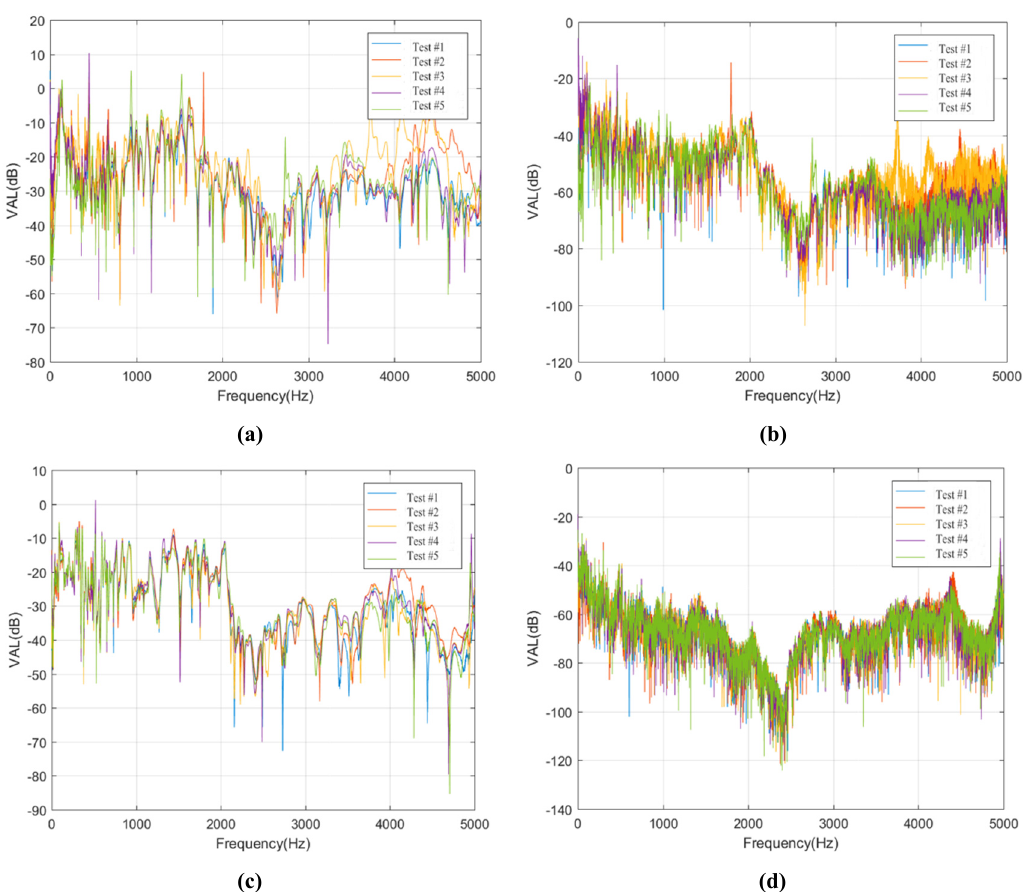
Figure 14. Acceleration level differences of different structural layers in ballastless tracks. ( a ) Acceleration level di ff erences of di ff erent structural layers in ballastless Acceleration level differences of sensor S1F1 in Condition #1; ( b ) Acceleration level differences of sensor Q1 in Condition #1; ( c ) Acceleration level differences of sensor S1J1 in Condition #2; ( d ) Acceleration level differences of sensor Q1 in Condition #2.